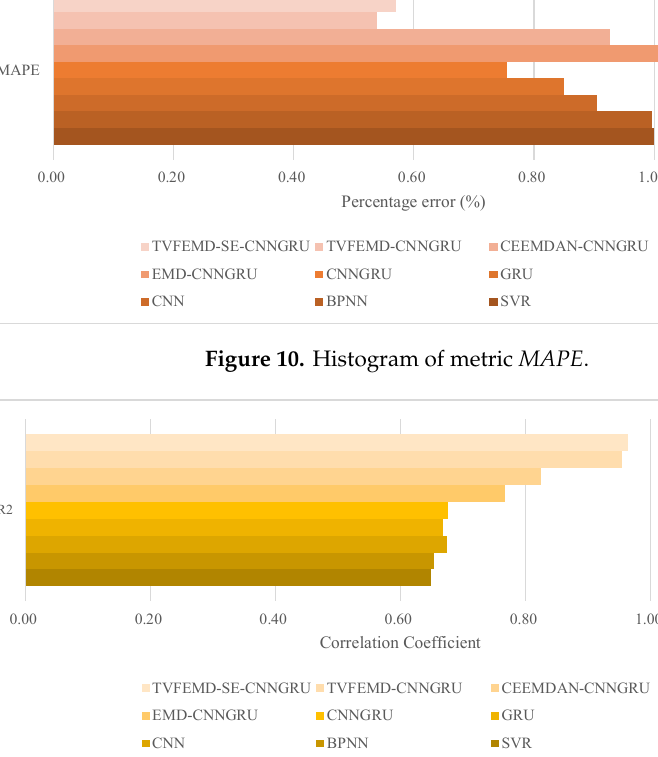
Figure 11. Histogram of metrics MAE and R 2 .